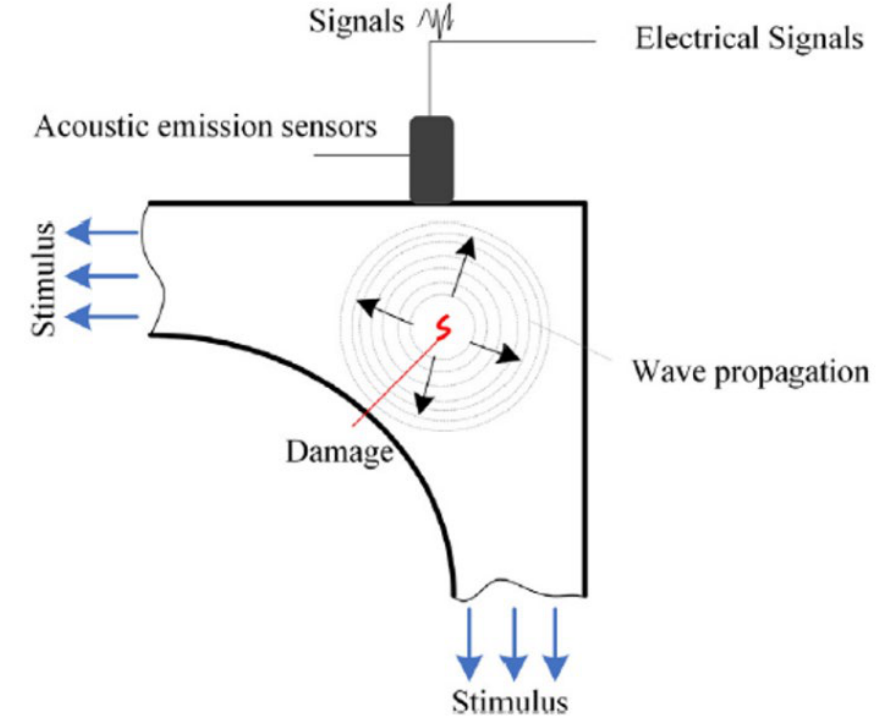
Figure 19. Acoustic emission technique